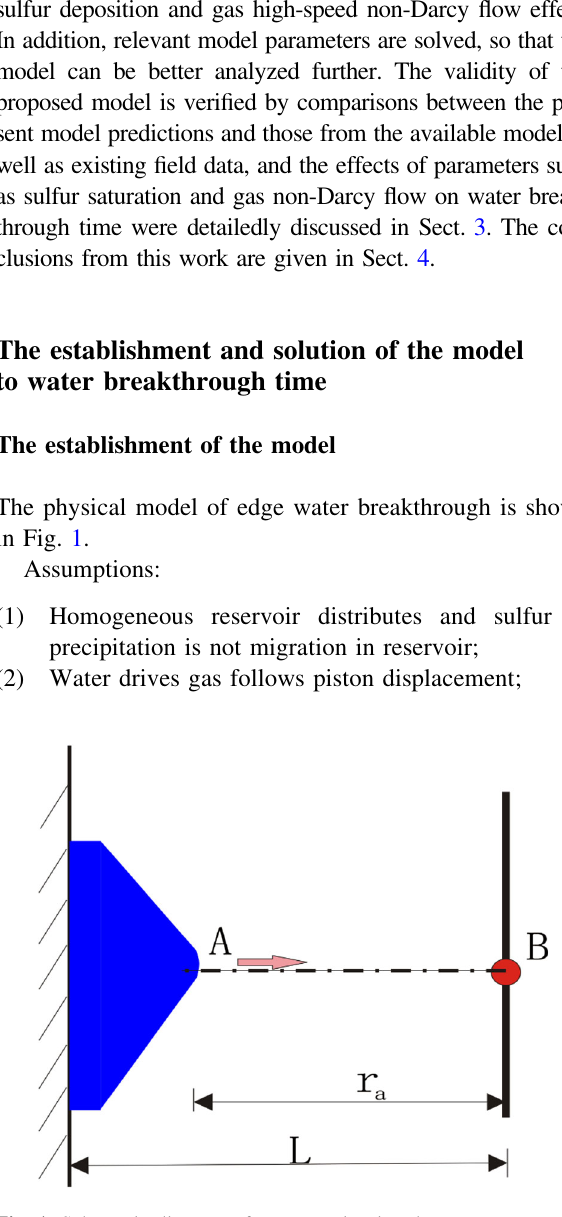
Fig. 1 Schematic diagram of water coning in edge